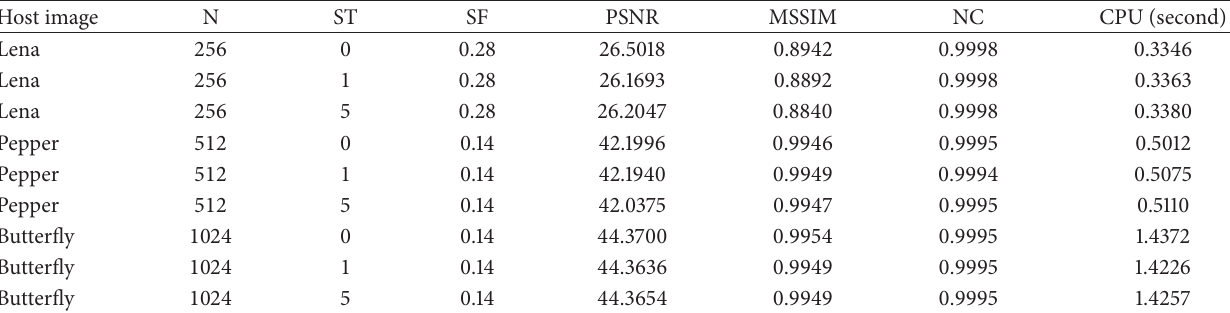
Table 2: PSNR, MSSIM, and NC values and CPU